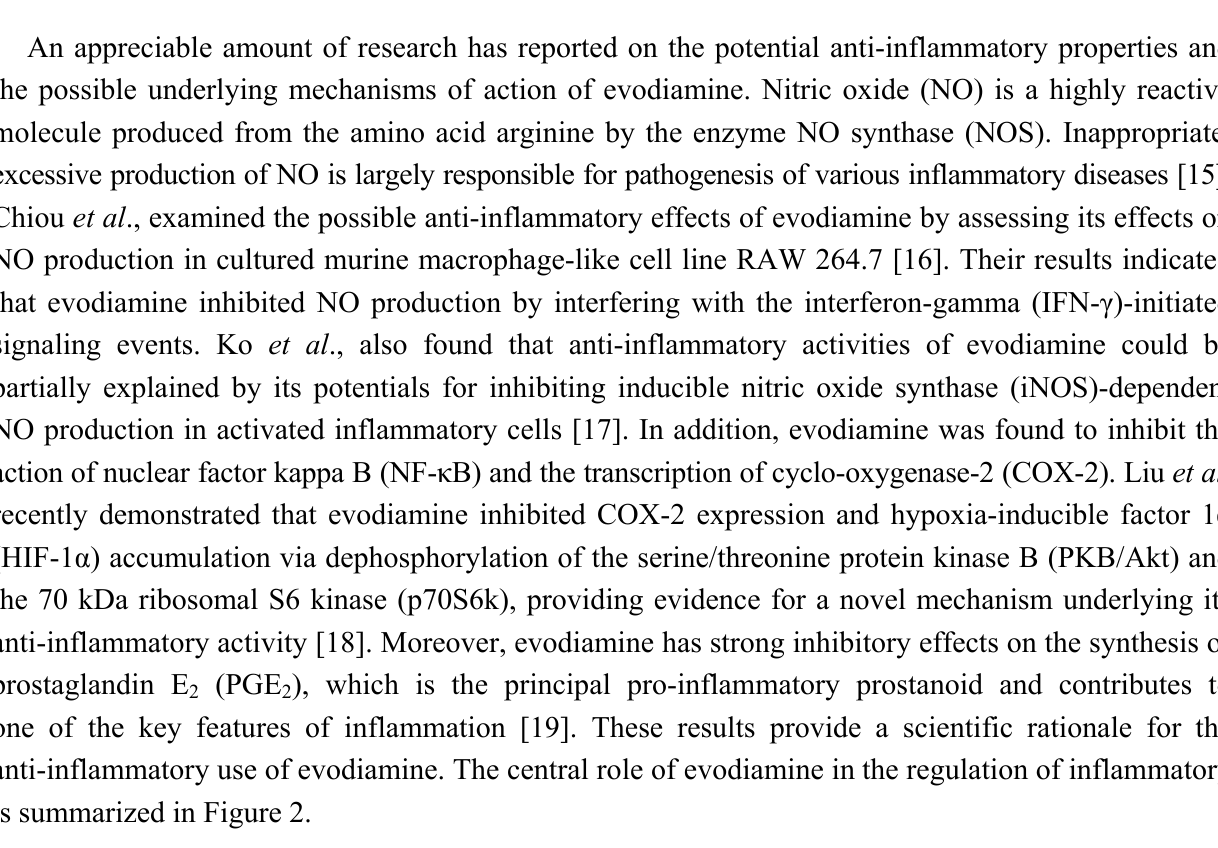
Figure 2. Demonstration of the key role of evodiamine in the regulation of inflammatory. T-lines indicate inhibitory